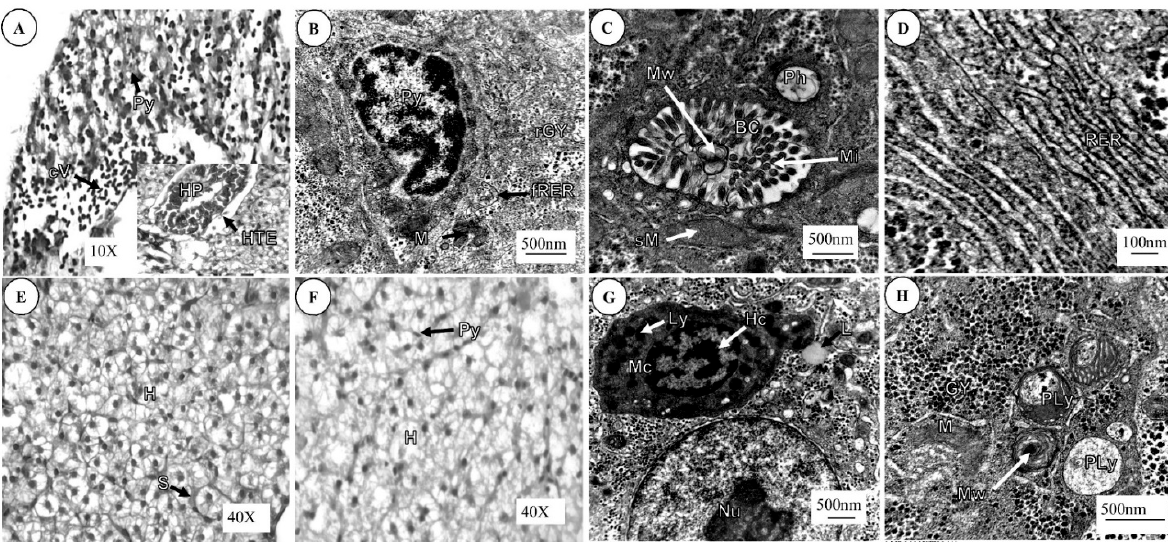
Figure 2. Alterations in hepato-architecture of C. carpio after exposure to malachite green and E. officinalis for 15 days. MG: ( A ) (10 × )—Liver with congested vessel (cV), pyknotic nucleus (Py), Hepatopancreas (HP) and hypertrophied erythrocytes (HTE). ( B ): Pyknotic nuclei (Py), fragmented RER (fRER), rGY—reduced glycogen content. ( C ): Swollen mitochondrion (sM), phagosomes (Ph) and membrane whorls (Mw) in Bile canaliculi. E. officinalis : ( D ): Parallel arrangement of copious RER. ( E ) (40 × )—Hepatocytes (H) with interspersed sinusoids (S). MG + E. officinalis : ( F ) (40 × )—Pyknotic nuclei (Py) in polygonal hepatocytes (H). ( G ): Macrophage (Mc) with lysosomes (Ly) and heterochromatin (Hc) nucleus, central nucleolus (Nu) in spherical nucleus and presence of lipid inclusion (L); ( H ): numerous phagocytic vesicles, phagolysosomes (pLy), mitochondria and glycogen